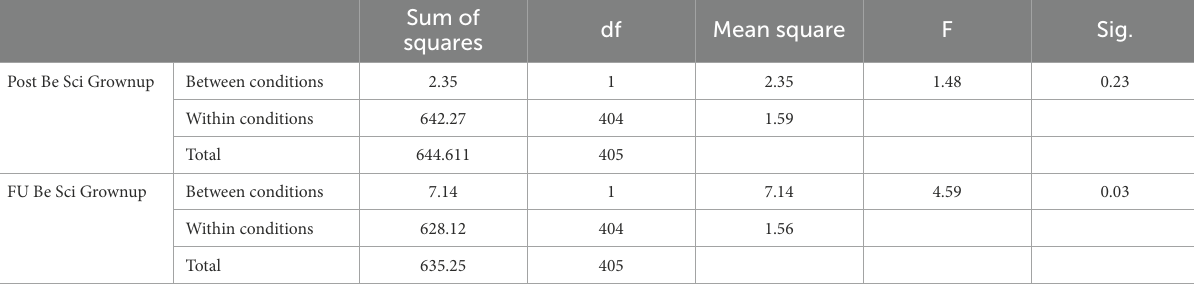
TABLE 6 Be a Scientist – Small screen to more immersive formats.